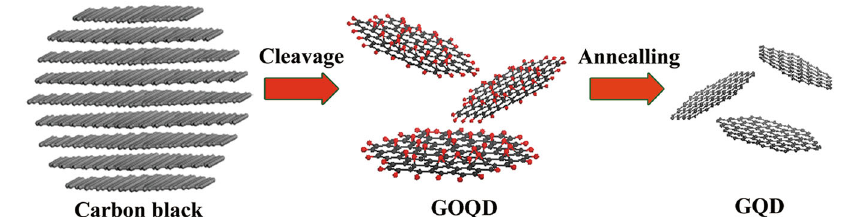
Fig. 1 Synthetic scheme for GQDs. The black and red balls denote carbon and oxygen atoms, respectively